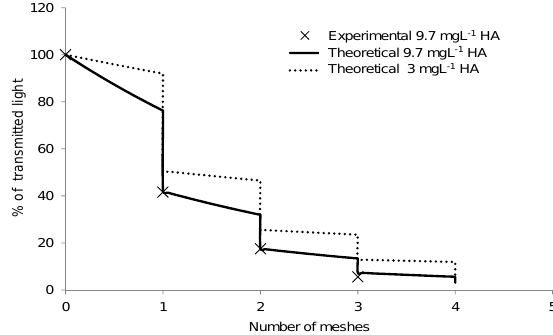
Figure 10. Light transmission through coated woven meshes ( r = 0.45) in a non-absorbing medium (distilled water). Measured intensities: ( (cid:7) ) 0.2cm mesh separation; ( × ) 1cm mesh separation.